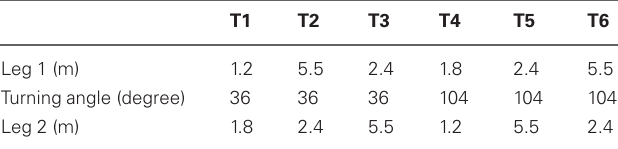
Table 1 | Six triangles were presented to the